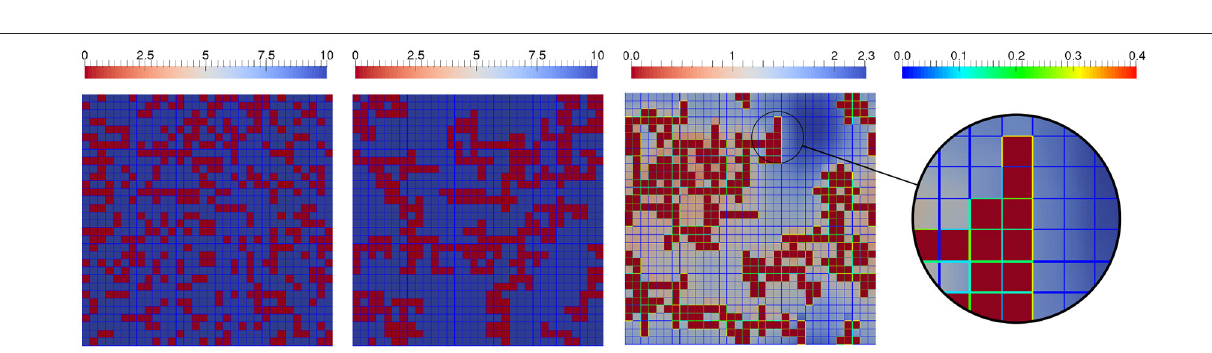
FIGURE 11 | Interplay of ions in solution with charged solids: Initial configuration (first image) of solid (red), quasi stationary, final configuration of charged solid in neutral solution (second), and final configuration of charged solid in ionic solution (third image) when heterogeneous reactions alter the total charges of solid cells’ edges. The zoom highlights charges on solid edges, the rainbow scale corresponds to the surface